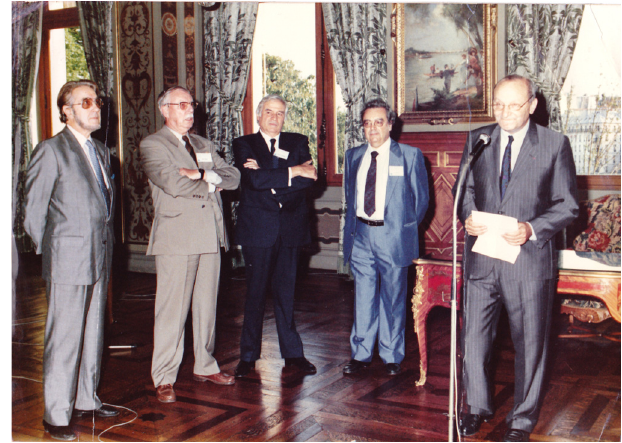
Figure 5. ICOPA Paris 1990. Of fi cial reception in Paris Townhall. From left to right: Jean-Antoine Rioux, Jean- Marie Doby, André Aeschlimann (president of the World Federation of Parasitologists), René Houin & Adrien Bedossa (deputy mayor for International